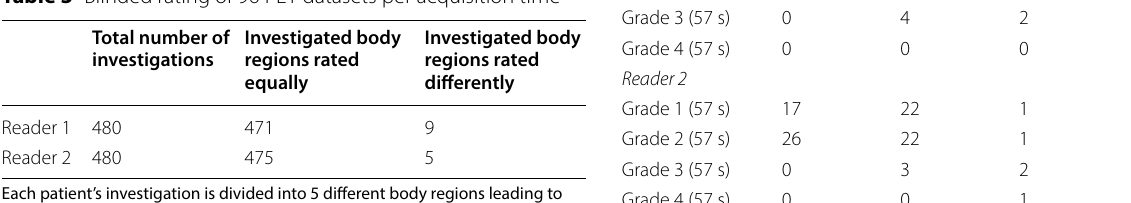
Table 3 Blinded rating of 96 PET datasets per acquisition time